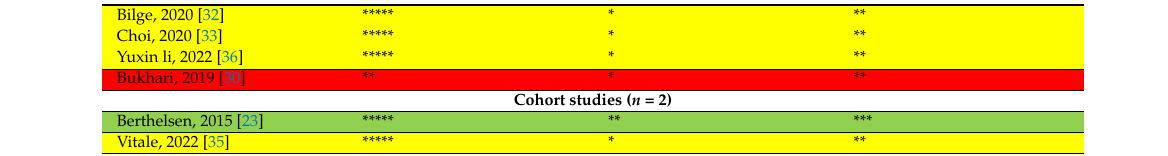
* = star. Green highlight = 9 stars or more. Yellow highlight = 7 or 8 stars. Red highlight = 6 stars or fewer.